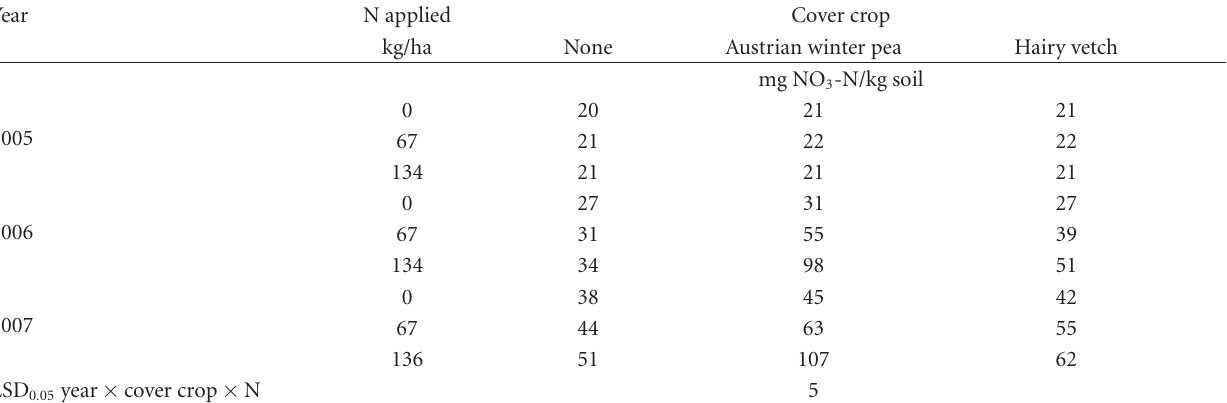
Table 5: Interaction of cover crop and N rate on soil nitrate present at planting in 2005, 2006, and 2007.